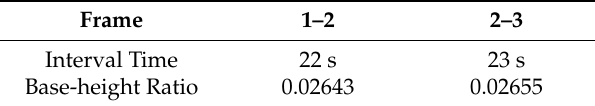
Table 1. Interval time and base-height ratio of sequence images.